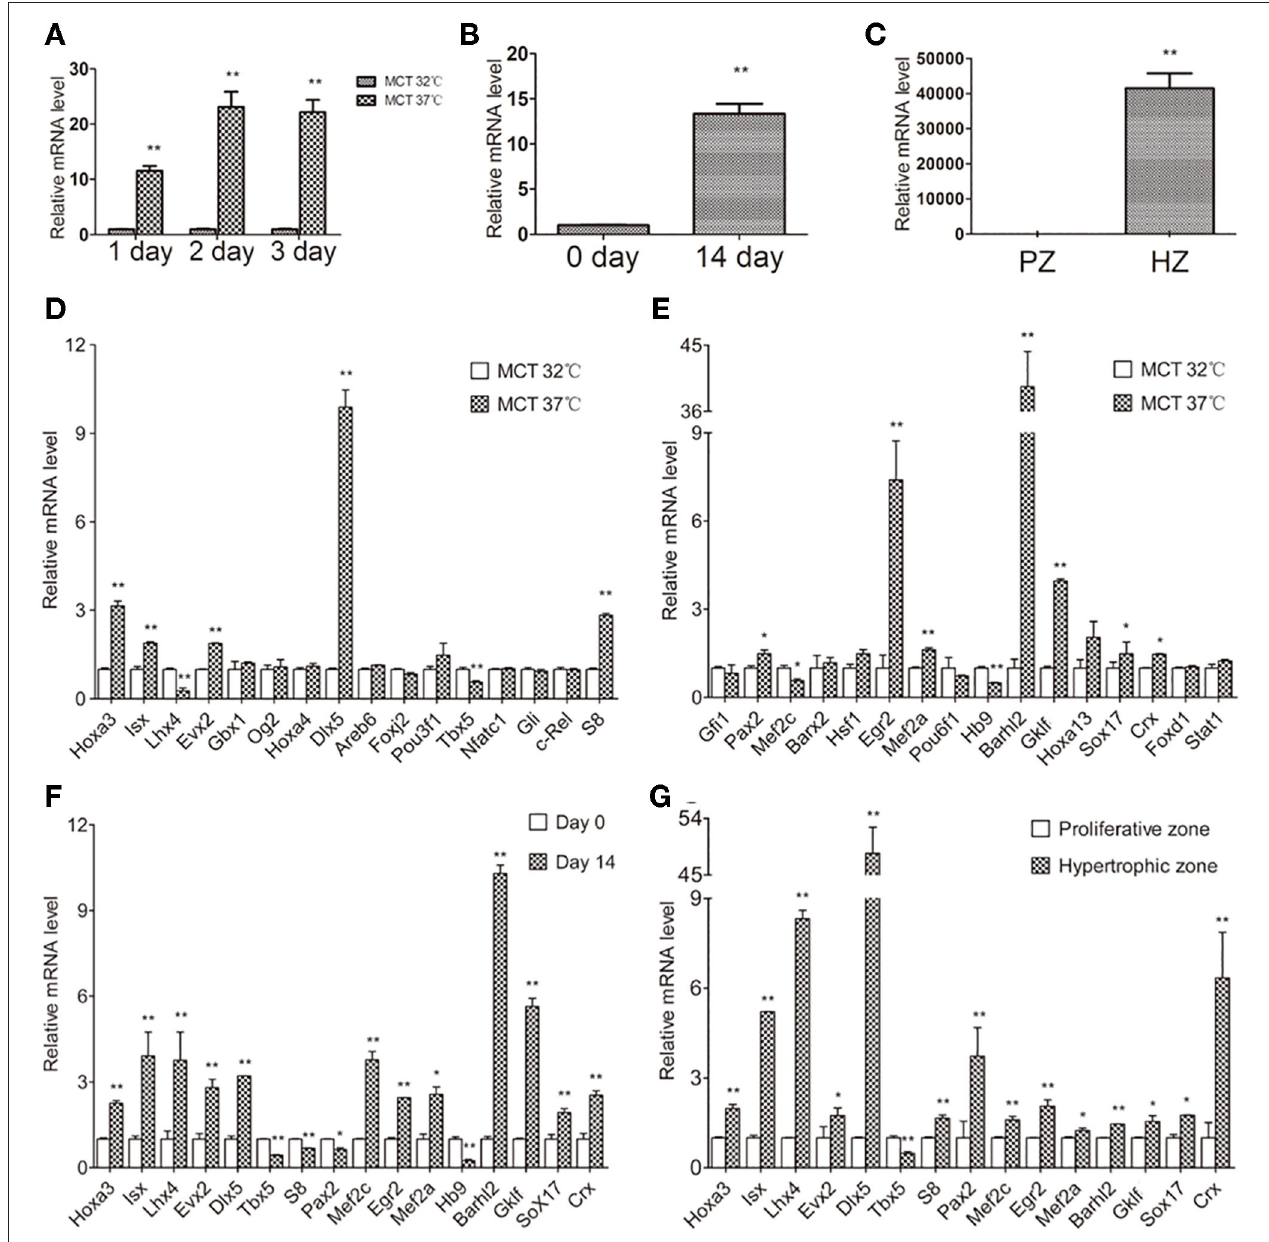
FIGURE 2 | Relative Col10a1 and candidate TFs mRNA levels in hypertrophic vs. proliferative chondrocytes. (A) Col10a1 mRNA levels were upregulated in hypertrophic compared with proliferative MCT cells at 1, 2, and 3 days. (B) Col10a1 mRNA level in ATDC5 cells was upregulated on day 14 compared with day 0. (C) Col10a1 mRNA was barely detectable in proliferative primary chondrocytes but was abundantly expressed in hypertrophic primary chondrocytes. (D,E) Hoxa3, lsx, Evx2, Dlx5, S8, Pax2, Egr2, Mef2a, Barhl2, GKlf, Sox17, and Crx were upregulated and Lhx4, Tbx5, Mef2c, and Hb9 were downregulated in hypertrophic MCT